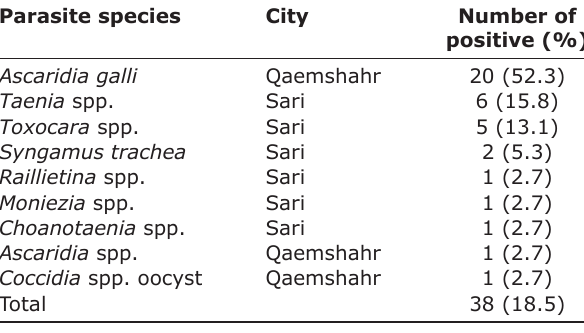
Table-1: Prevalence of intestinal parasites in feces of migratory swallows according to parasite species and place in Mazandaran